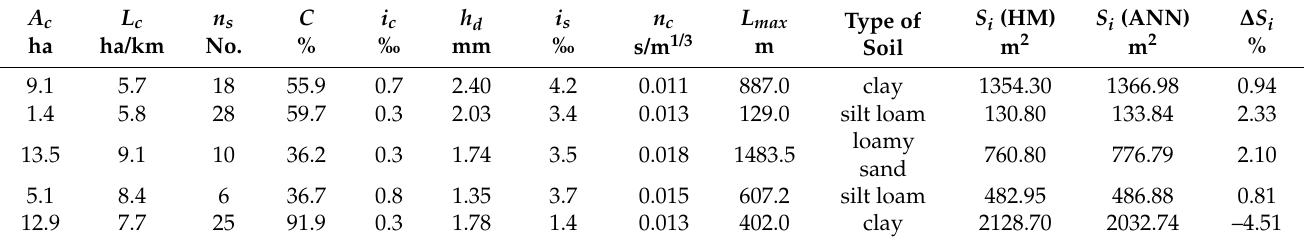
Table A4. Comparison of the required areas of the fully water-saturated infiltration tank ( S i ) generated for a random combination of input parameters from the MLP 12-8-1 (ANN) artificial neural network (ANN) and those obtained from the hydrodynamic simulations (HM) (designations as in Figure 2).